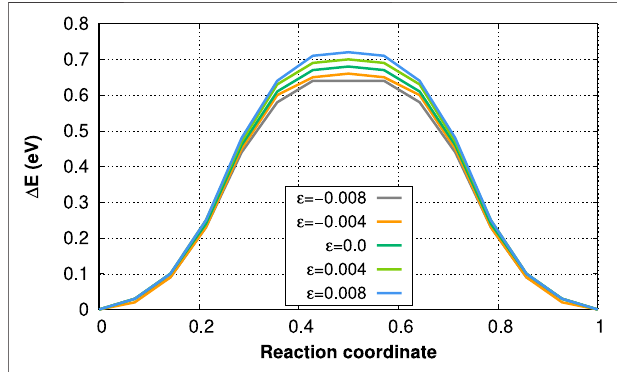
FIGURE3| Minimumenergy pathforanadatomhopping alonga 〈 111 〉 direction on a W ( 110 ) surface at various applied equibiaxial strain levels.